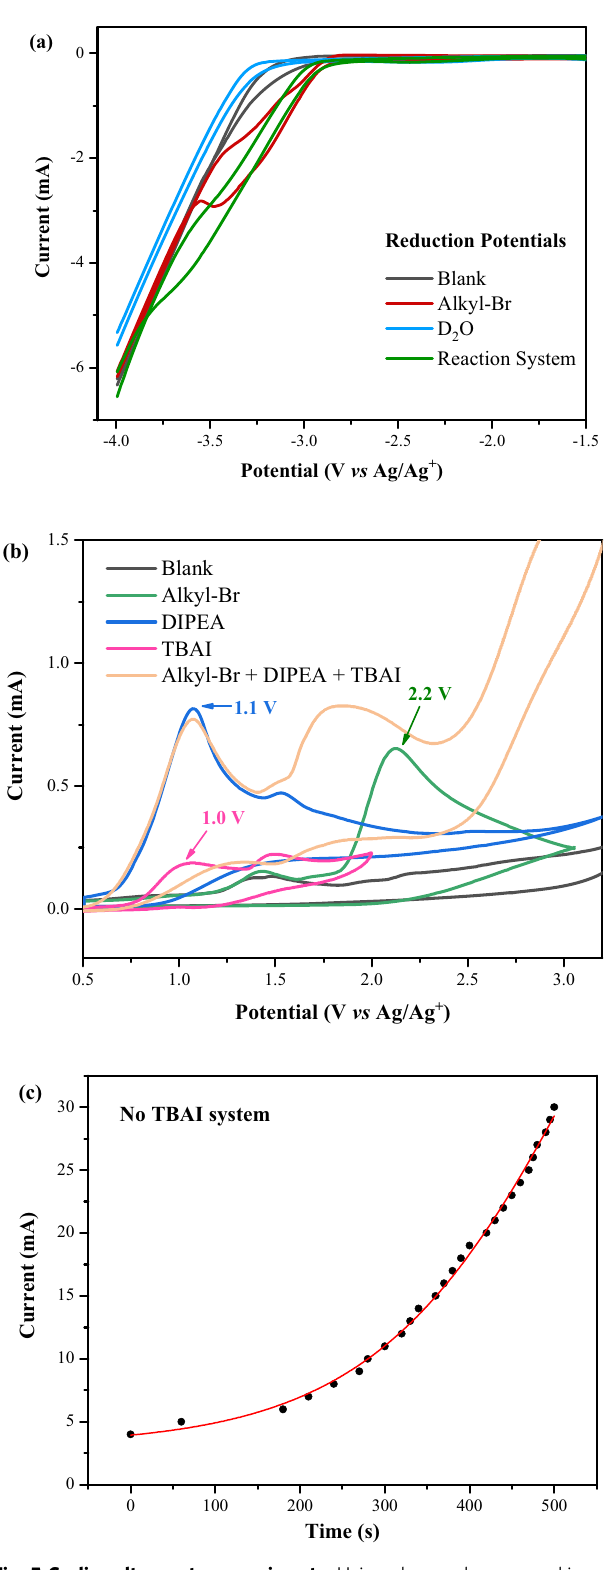
Fig. 5 Cyclic voltammetry experiments. Using glass carbon as working electrode, Pt plate and Ag/Ag + as counter and reference electrode. (Related compounds (5 mM) in MeCN containing 0.1 M n Bu 4 NBF 4 , 100 mVs − 1 ). a Reduction potentials. b Oxidant potentials. c Variation curve of current without